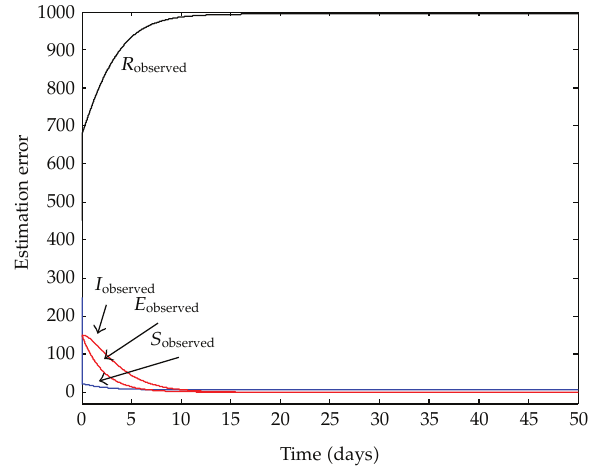
Figure 7: Time evolution of the positive observed